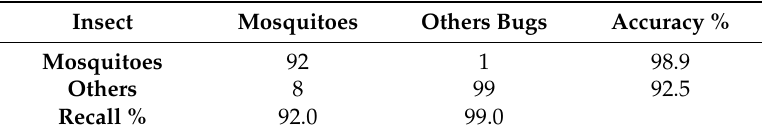
Table 4. The result of the classification of mosquitoes and others bugs using SVM